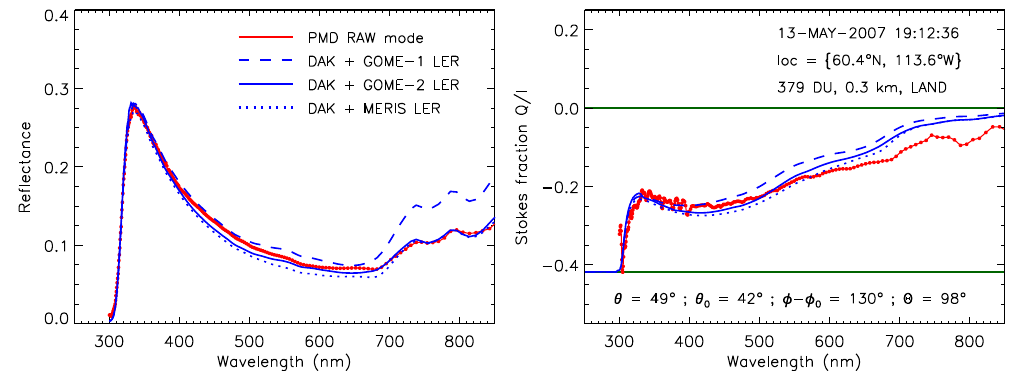
Figure 4. Earth reflectance and polarisation Stokes fraction Q/I measured by GOME-2 for case 2 indicated in Fig. 2 (in red). The simulated spectra (in blue) were calculated with different surface albedo inputs (see legend) and were convolved with the PMD slit function. For the Stokes fraction Q/I the agreement between measurement and simulation is good in the UV but less good for the longer wavelengths.